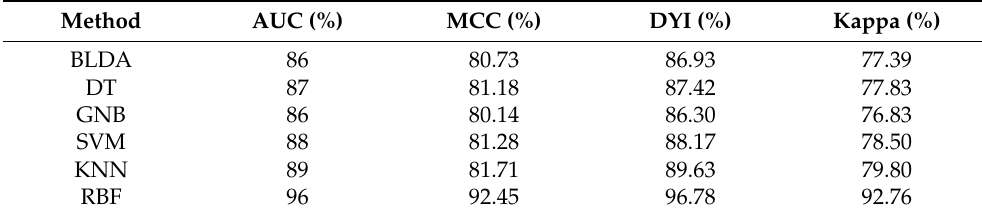
Table 3. Values of AUC, MCC, DYI, and Kappa of all the tested machine learning models and the proposed method implemented.